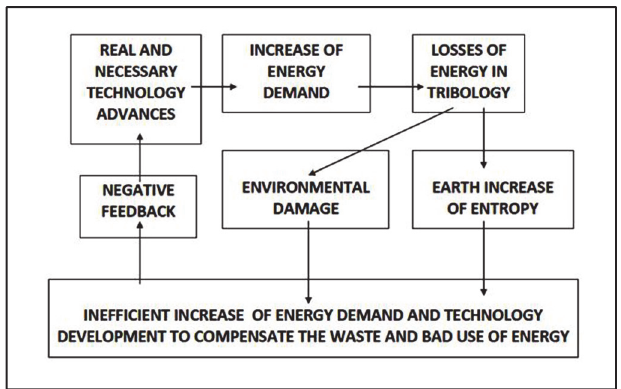
Fig. 1. Energy optimal performance related to requirement for tribological optimization of mathematical models in power plants. It is presented in the flow chart both the meaning of the necessary technological advances and the concept of inefficient use of energy. The importance of entropy icrease is